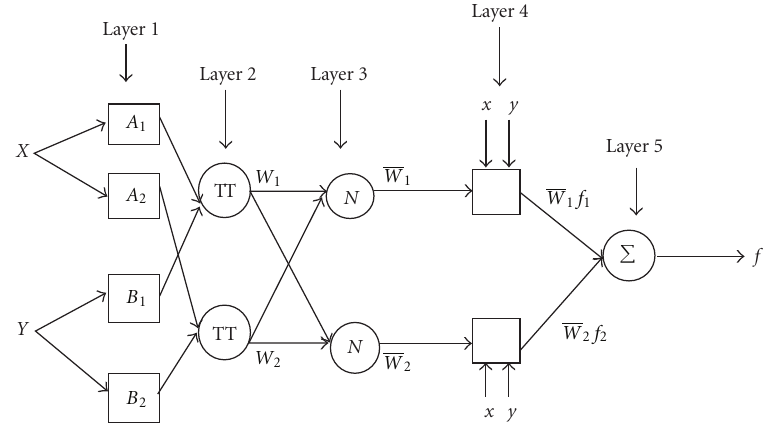
Figure 3: AN ANFIS